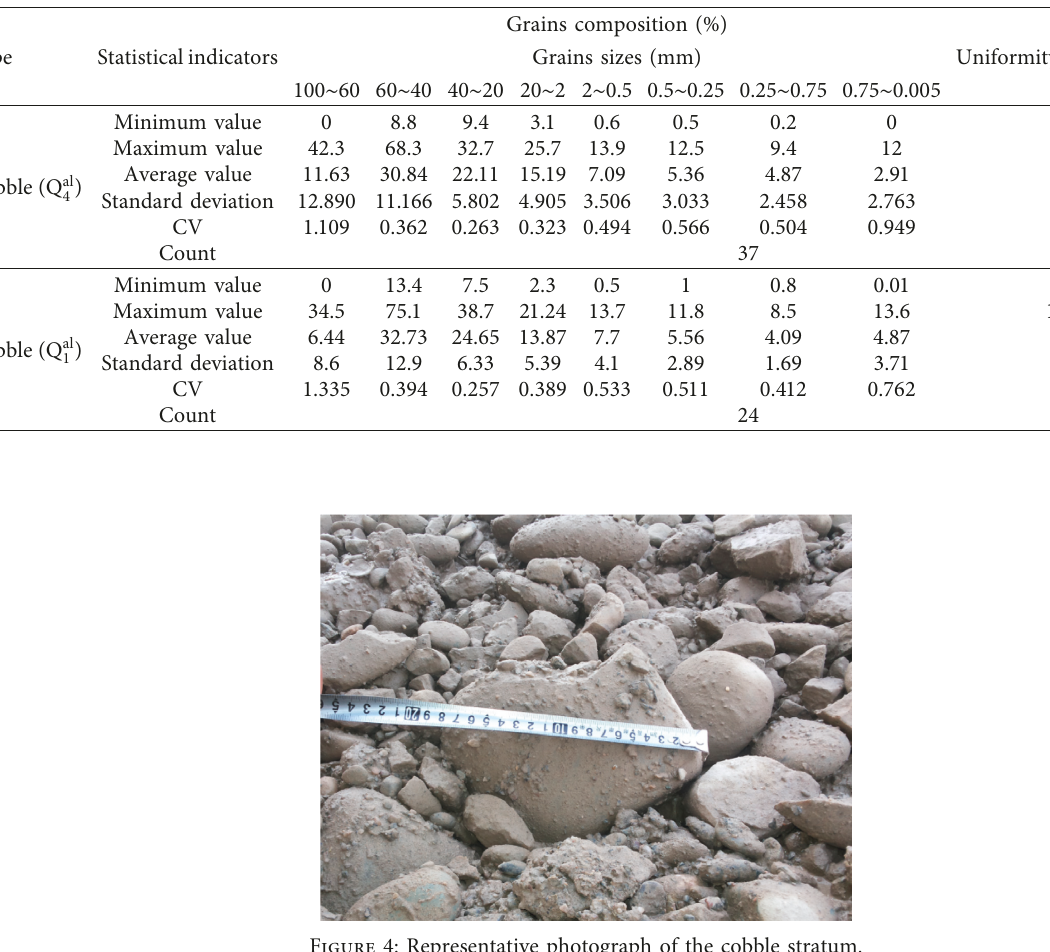
Figure 3: Profile of the geological section of the Lanzhou Yellow River Tunnel.